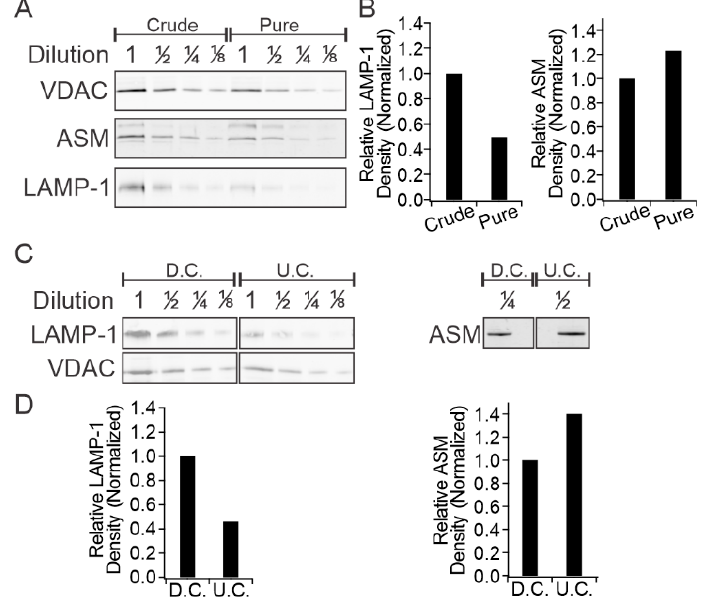
Figure 5. Colocalization between ASM and mitochondrial markers. ( A ) Western blot analysis of human RPE cell mitochondria at varying levels of purity and ( B ) associated optical density quantitation; ( C ) Western blot analysis of ARPE-19 cell mitochondria at varying purity levels and associated optical density quantitation ( D ). LAMP-1 = lysosome associated membrane protein 1, VDAC = voltage dependent anion channel, crude = one 8000× g centrifugation, pure = three 8000× g centrifugations, D.C. = differential centrifugation, U.C. = sucrose step-density ultracentrifugation.